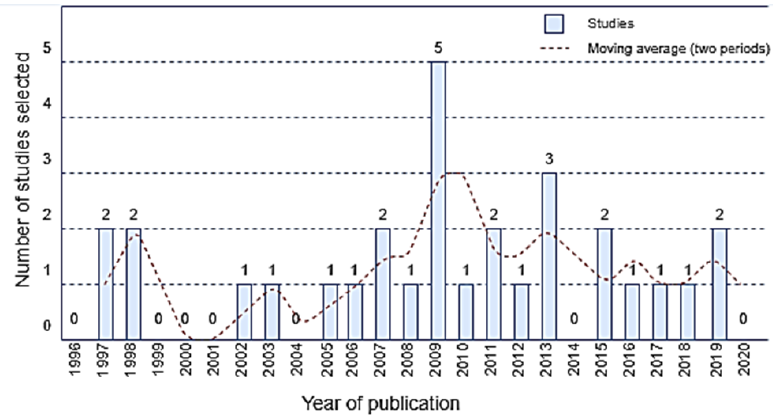
Figure 3. Number of studies published per